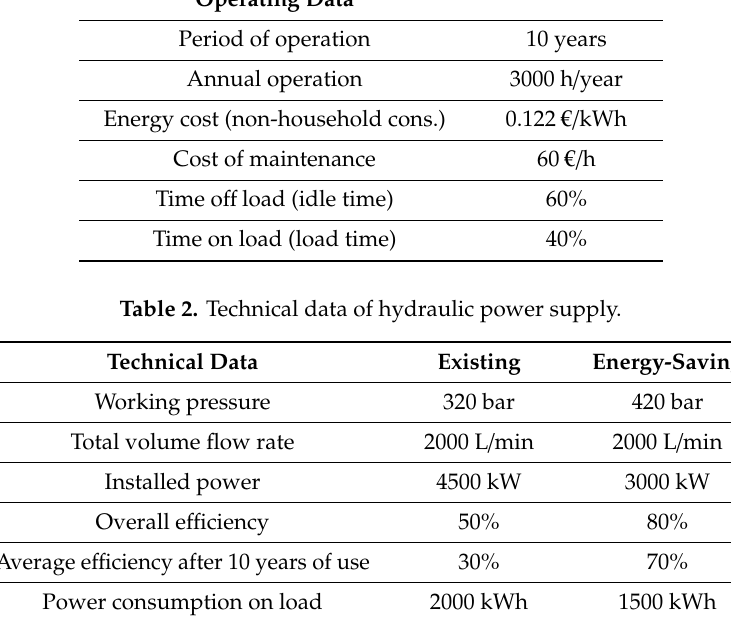
Table 1. Operating data of hydraulic power supply.